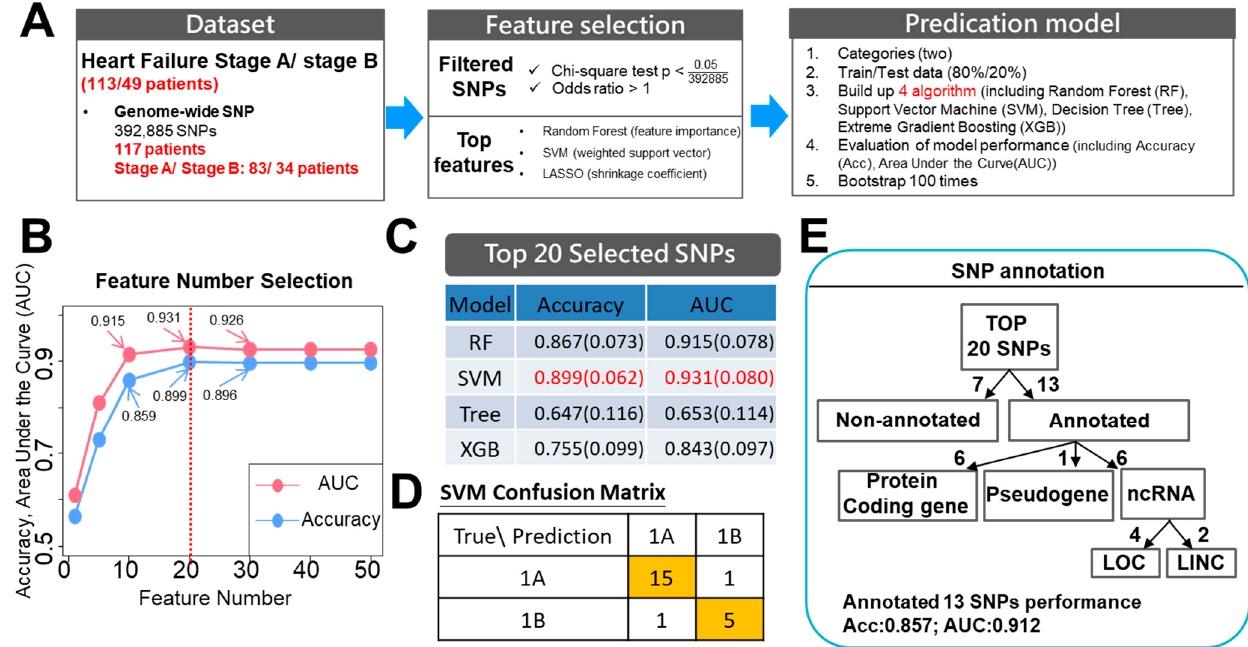
Figure 2. Prediction models built based on the clinical features and genome-wide SNPs were used to classify Stage A and Stage B using machine-learning methods. ( A ) Machine-learning workflow to select reliable and predictable features to build prediction models for the group classification. ( B ) The accuracy and AUC of the SVM model with different feature selection numbers. ( C ) Classification performance of the four machine-learning algorithms with selected feature subsets from genome-wide SNPs. ( D ) The SVM confusion matrix used for prediction accuracy. ( E ) Classification of selected